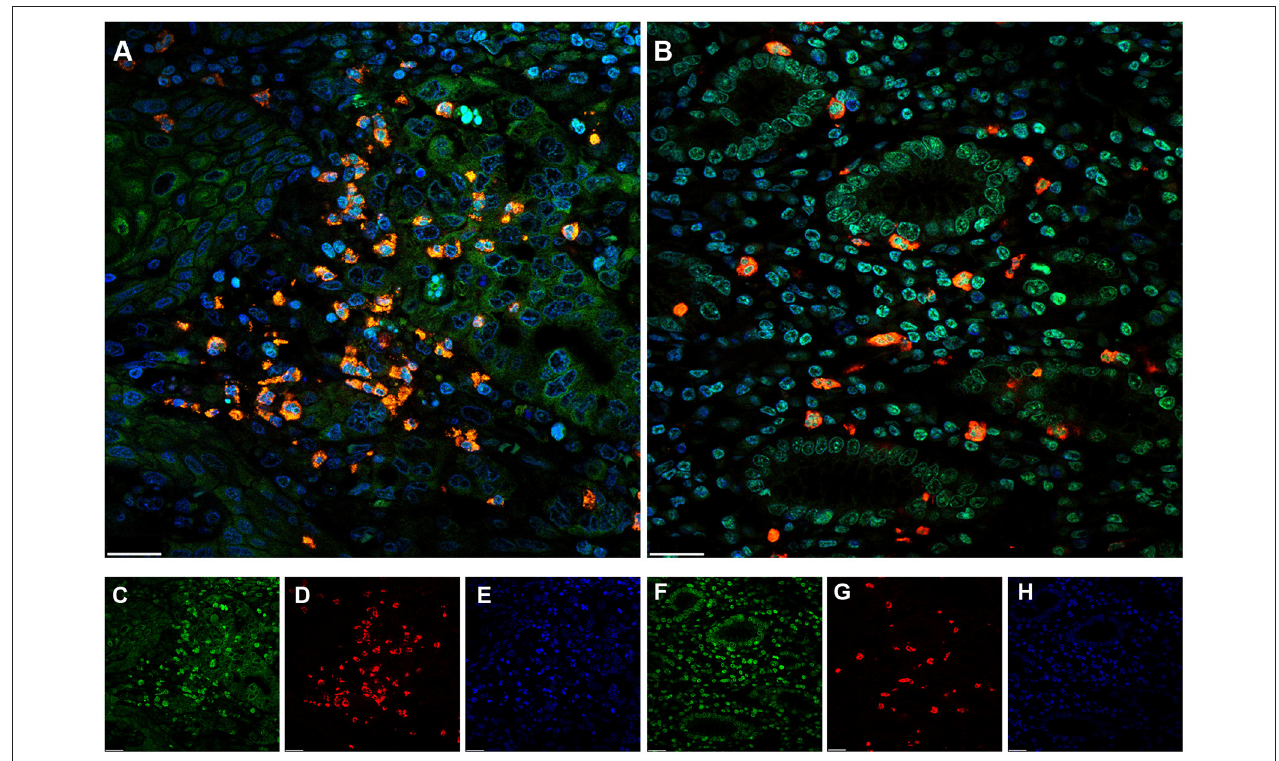
FIGURE 1 | Immunofluorescence staining of neutrophil extracellular traps (NETs) in gastric cancer (GC). (A) Colocalization of neutrophil elastase (NE) and Circulating histone H3 (H3Cit) in the microenvironment of tumor tissue. (B) Colocalization of NE and H3Cit in the microenvironment of paratumor tissue. (C) H3Cit. (D) NE. (E) DAPI. (F) H3Cit. (G) NE. (H) DAPI. Scale bars: 25 µ